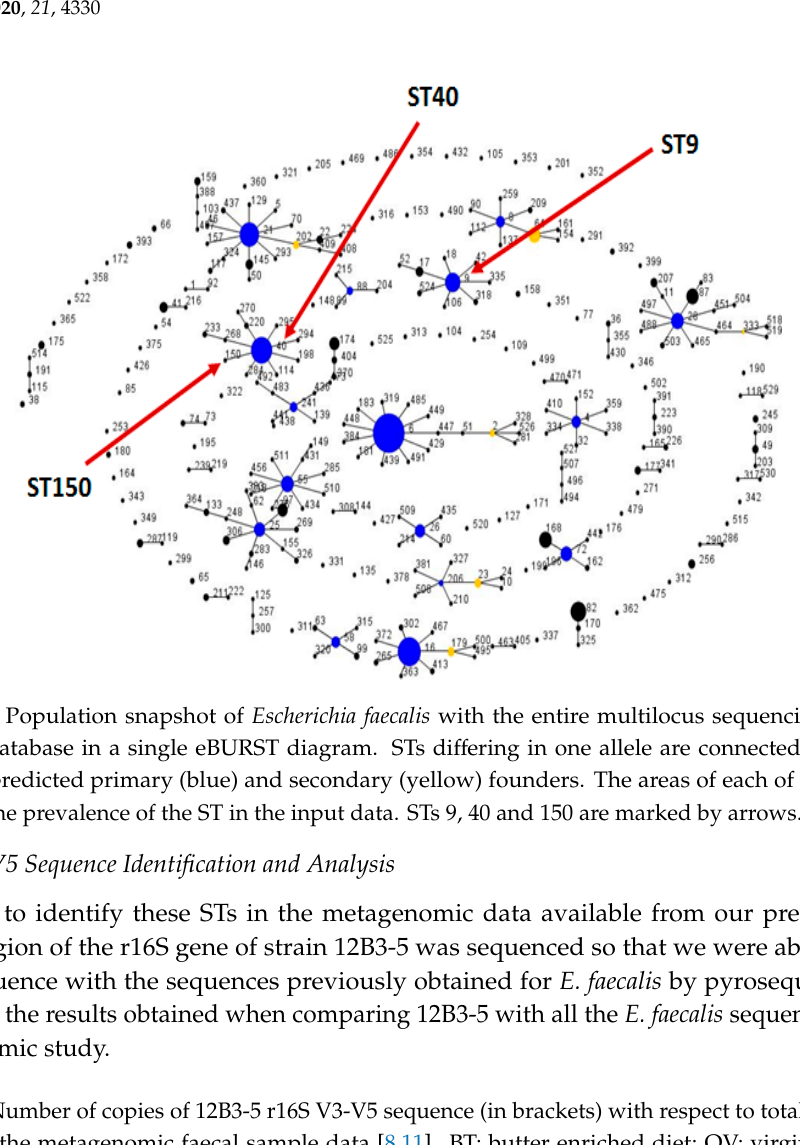
Table 2. Number of copies of 12B3-5 r16S V3-V5 sequence (in brackets) with respect to total E.